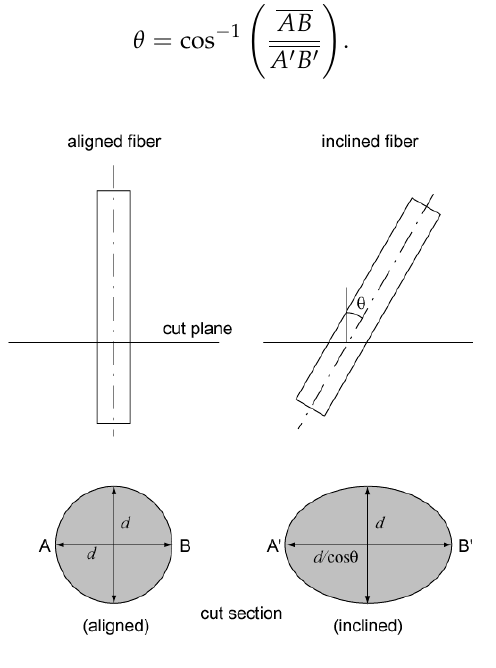
Figure 5. Schematic diagram for how to calculate fiber inclined angle.